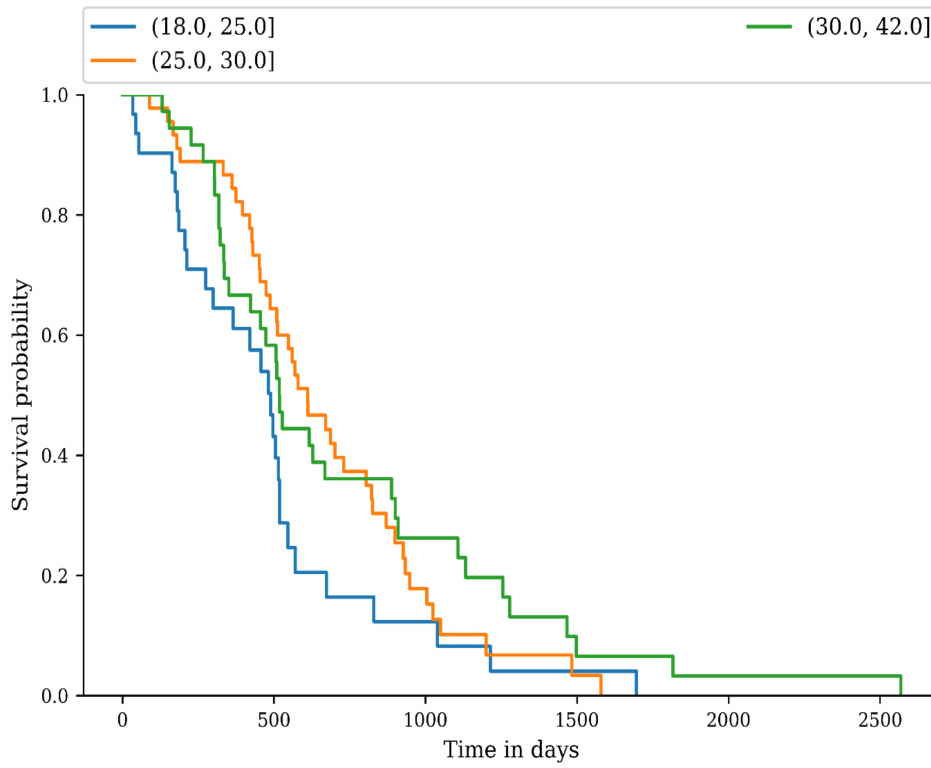
Figure 3. Progression of prostate cancer based on